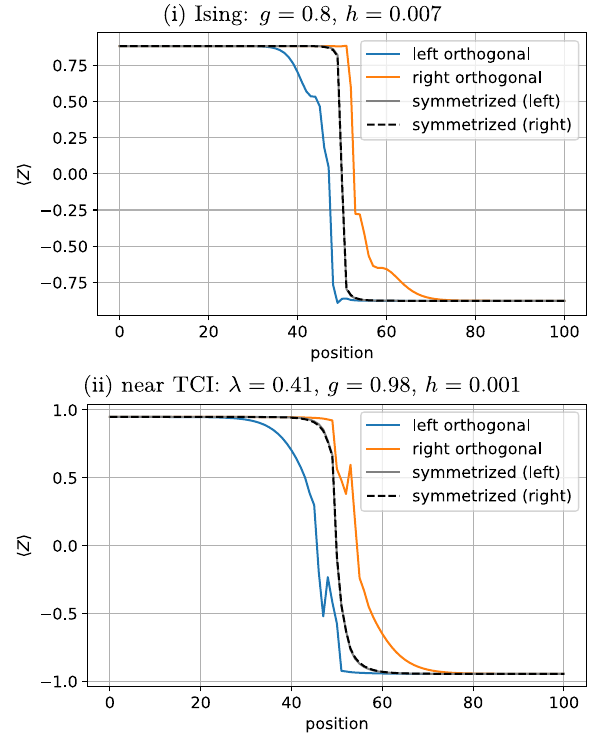
FIG. 15. Spin expectation values of a kink position MPS | κ j (cid:3) for (i) the Ising model and (ii) close to the TCI point. The bond dimension is D = 8 for the Ising data, and D = 18 for the TCI data. We plot the spins for various ways of fixing the momentum- eigenstate freedom: the left and right orthogonal conditions, Eq. (C4) or (C6), and the reflection-symmetric conditions (C17), beginning from a B tensor optimized using either the left or right conditions (since this makes a small physical difference to the result—see Appendix C